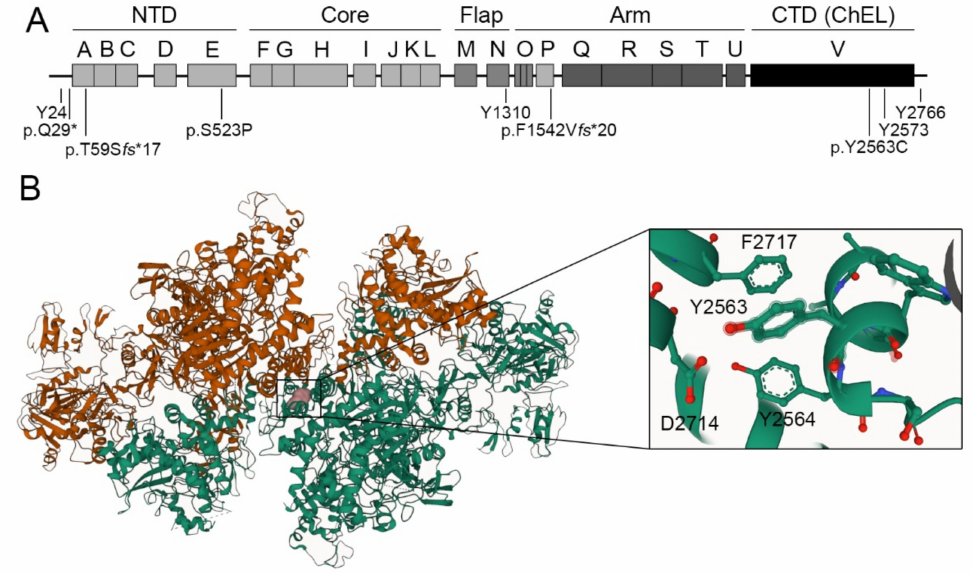
Figure 1. Schematic representation of detected TG variants. ( A ) Representation of TG variants in the primary structure of the human TG monomer. In the context of the 3D structure, the monomer of TG was divided into five regions: the amino-terminal domain (NTD), and the core, flap, arm, and carboxy-terminal domains (CTD), corresponding to the dimeric choline esterase-like domain (ChEL). Primary sequence-based internal homology domains named type 1, 2, and 3 TG-like repeats, as well as the ChEL domain are labeled as A to V. The hormonogenic tyrosines Y24, Y1310, Y2573, and Y2766 are indicated. ( B ) Representation of the residue p.Y2563C (colored in pink) in one monomer of the cryo-electron microscopy structure of TG homodimer (PDB ID 6SCJ). Monomers are displayed in orange and green. Close-up view of the structure showing Y2563-interacting residues Y2564, D2714 and